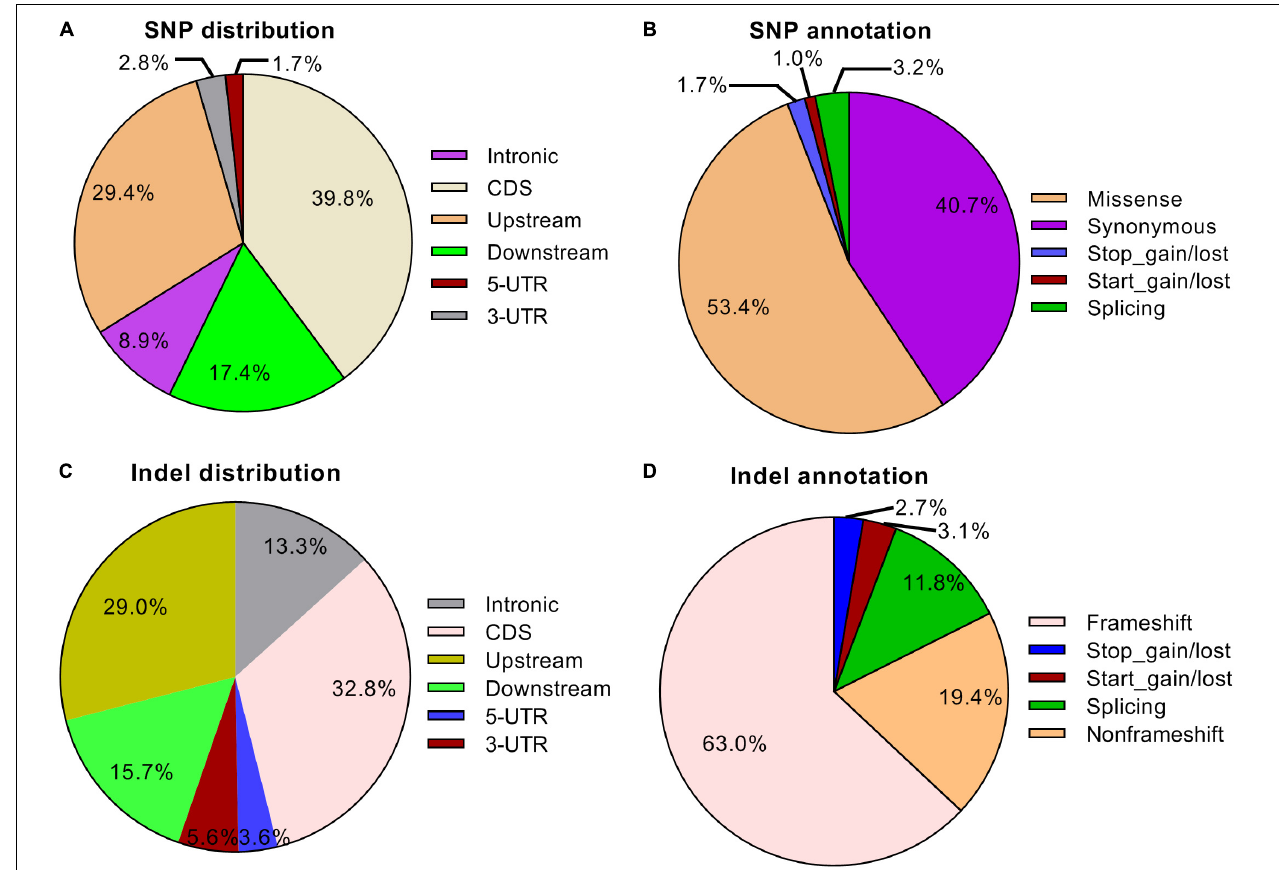
FIGURE 4 | Distribution and functional annotation of exomic variations in 12 mutant lines. (A) Distribution of SNPs in different regions in the exome. (B) Functional annotation of SNPs in structural genes. (C) Distribution of Indels in different regions in the exome. (D) Functional annotation of Indels in structural